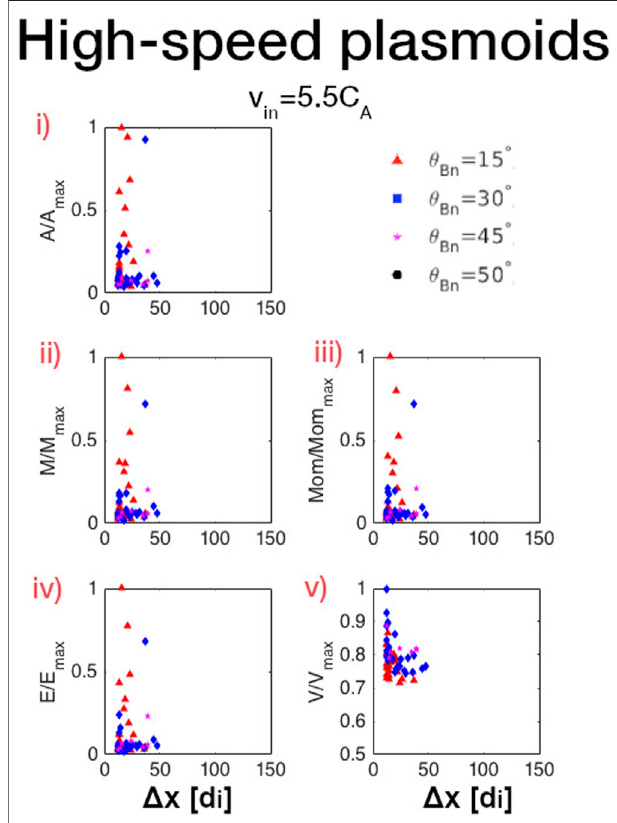
FIGURE 10 | Scatter plots of properties of high-speed plasmoids as a function of their distance from the shock. The format is the same as in Figure7 .Theformatisthesameasin Figure7 exceptthatrunswithV in =3.3 C A and 4.5 C A are missing since no high-speed plasmoids were formed in